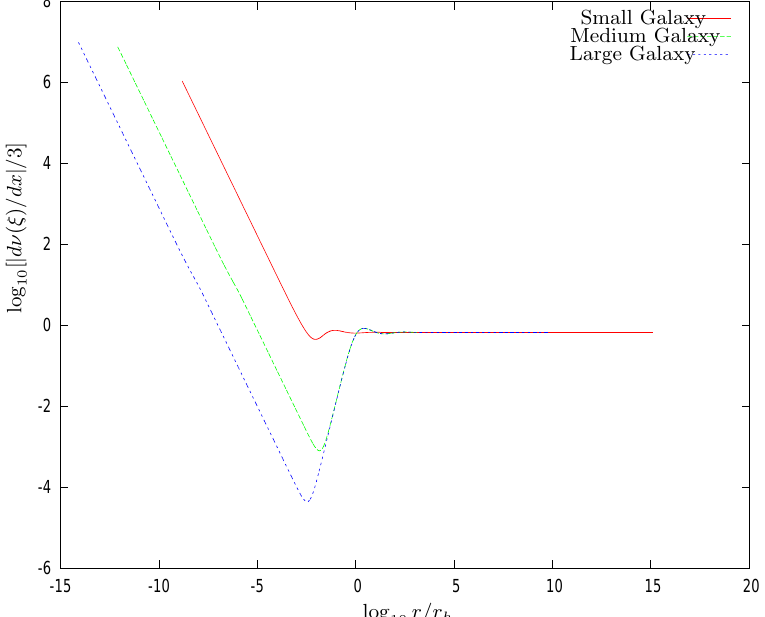
FIG. 1: The dimensionless chemical potential log ν ( ξ ) vs. log ( ξ/ξ h ) = log ( r/r h ) for the three illustrative galaxy solutions with central SMBH defined by eq.(3.7). ν ( ξ ) is negative for r > r A = l 0 ξ A and WDM exhibits there a classical dilute Boltzmann gas behaviour, while WDM exhibits a compact quantum gas behaviour for r < r A where the chemical potential is positive. The point r A where the chemical potential vanishes defines the transition from the quantum to the classical galaxy WDM behaviour . r A is at the downward spike of log ν ( ξ ) where ν ( ξ ) vanishes.